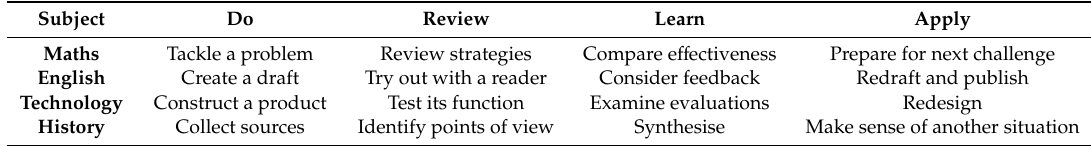
Table 2. Examples of active learning in a range of